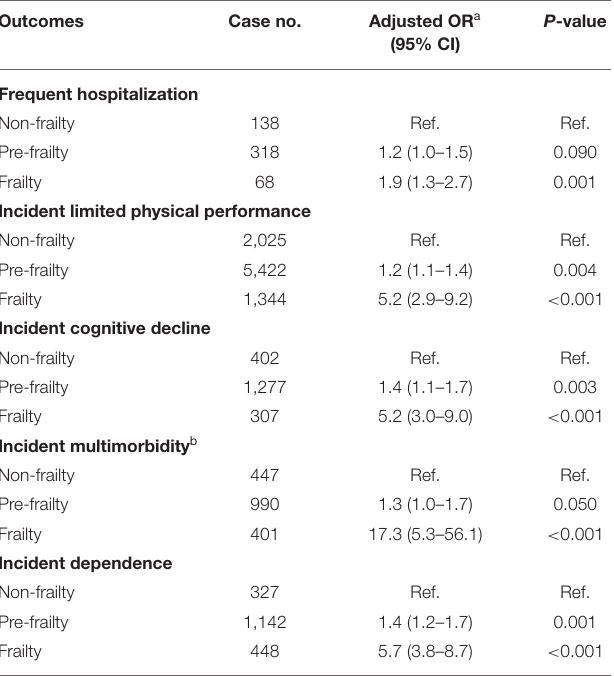
TABLE 2 | Association between pre-frailty/frailty and the risk of multiple adverse outcomes. Outcomes Case no. Adjusted OR a